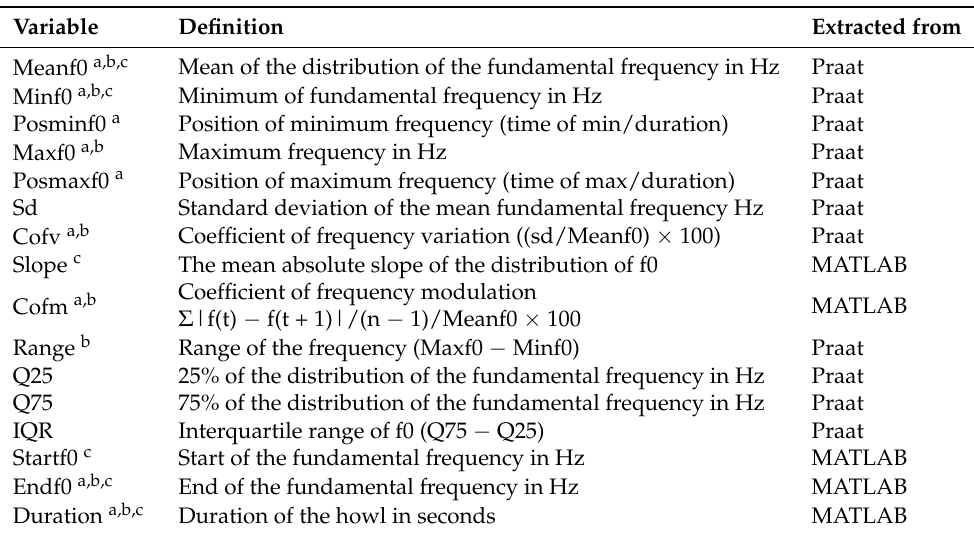
Table 2. Definition of acoustic variables assessed in wolf howls to investigate identification of subspecies and individual identification of